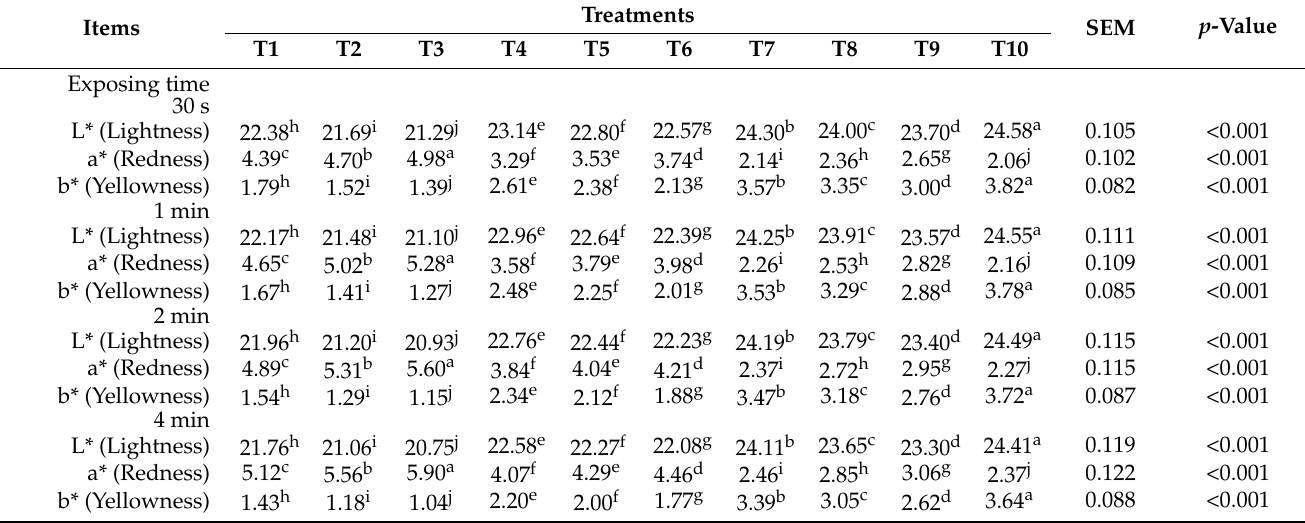
Table 1. Effect of high concentration levels of different gas exposing conditions on Hemoglobin solution (n = 10).